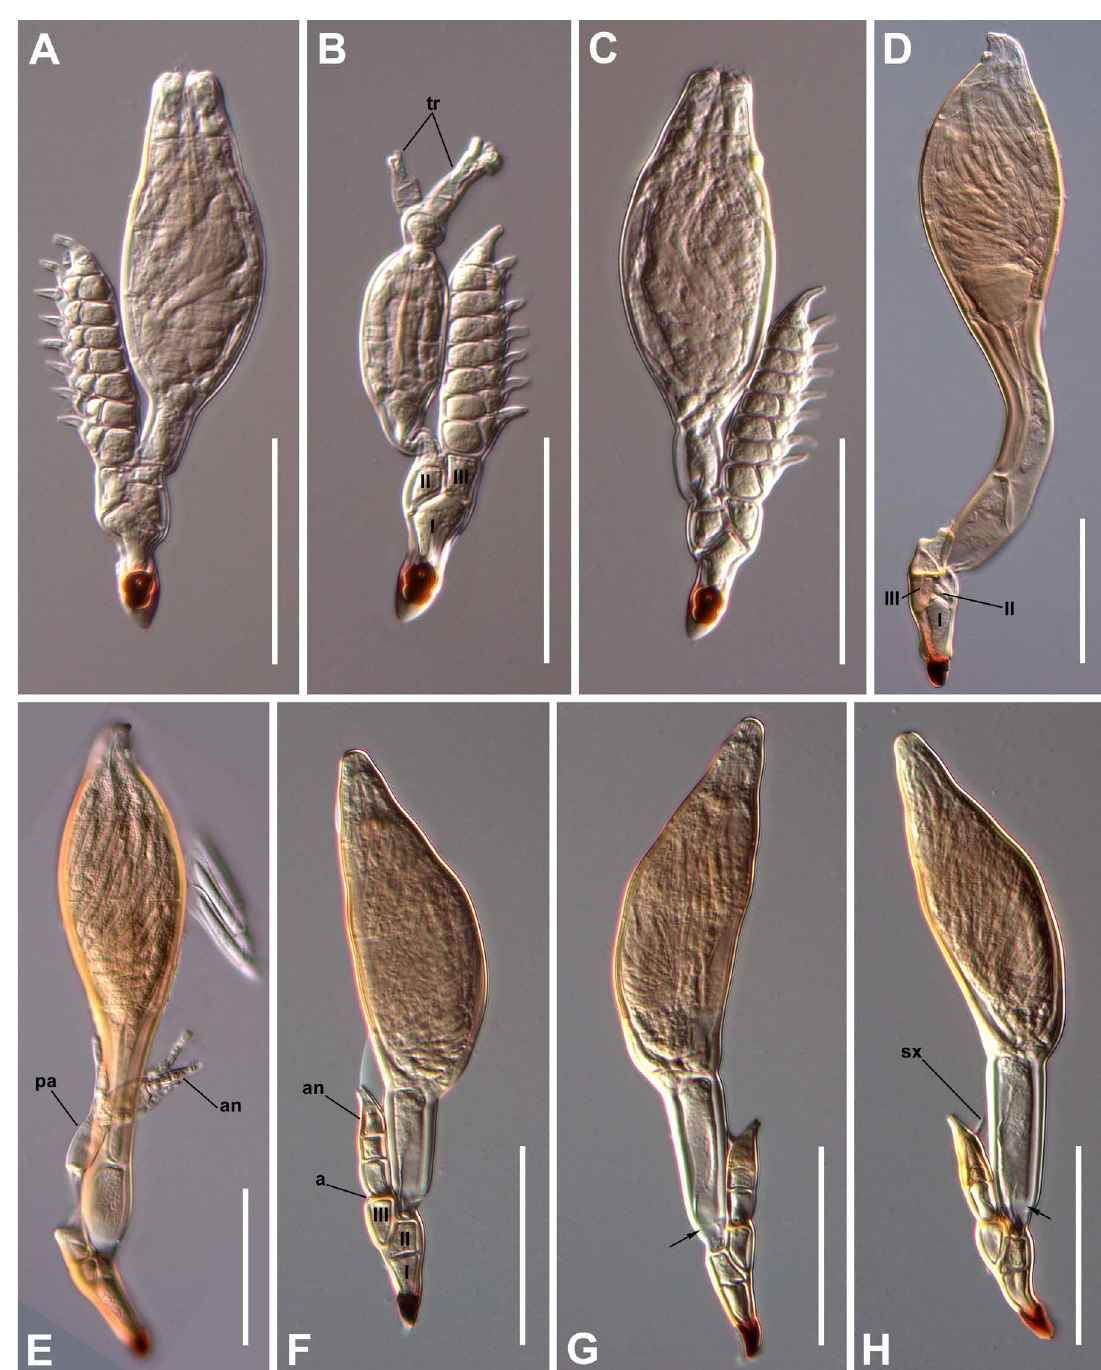
Fig. 46. A – C . Acompsomyces stenichni (Scheloske) I.I.Tav. A , C . Submature thalli. B . Immature thallus showing the trichogyne (tr) and cells of receptacle (I, II, III). – D – E . Aphanandromyces audisioi W.Rossi. Mature thalli. D. With labelled cells of receptacle (I, II, III). E . With labelled primary appendage (pa), and antheridia (an). – F – H . Bordea denotata Haelew. & De Kesel. Mature thalli. Different parts of the thallus are labelled. Abbreviations: a = primary septum; an = antheridium; sx = spinous process or remains of the original spore apex; I, II, III = cells of primary receptacle. Arrows = cytoplasmatic constraint or septum-like marking above septum II–VI. Scale bars: 50 µm. Photographs from slides ZMUC C-F-123039 (A–C), ZMUC C-F-122509 (D), ZMUC C-F-122633 (E), ZMUC C-F-122556